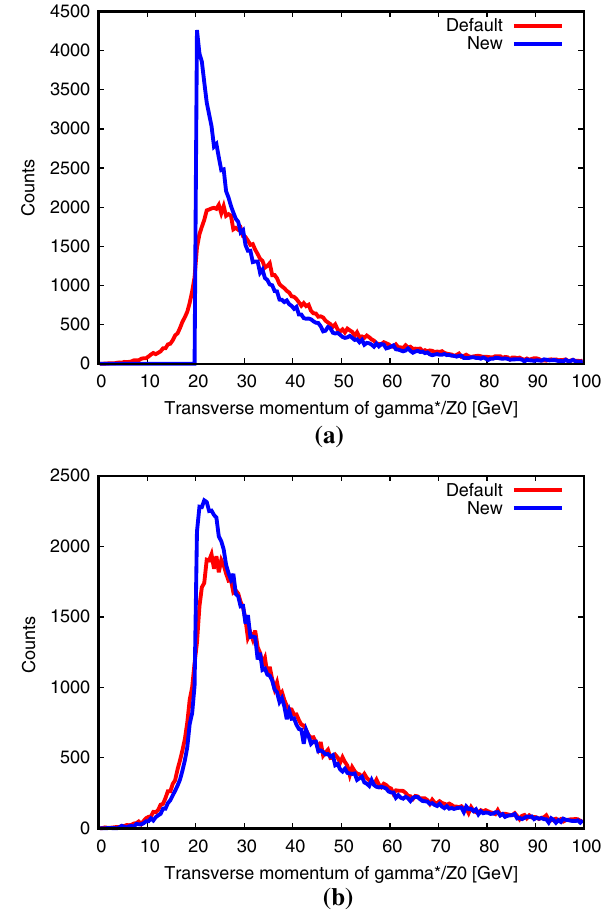
Fig. 9 Transverse momentum of γ ∗ / Z 0 at 7 TeV LHC, with ˆ p ⊥ > 20 GeV in the 2 → 2 process: a for q + q → γ ∗ / Z 0 + g, b for q + g → γ ∗ / Z 0 + q. The new dipole approach is compared with the old default one. p ⊥ shifts due to primordial k ⊥ are not included here for simplicity